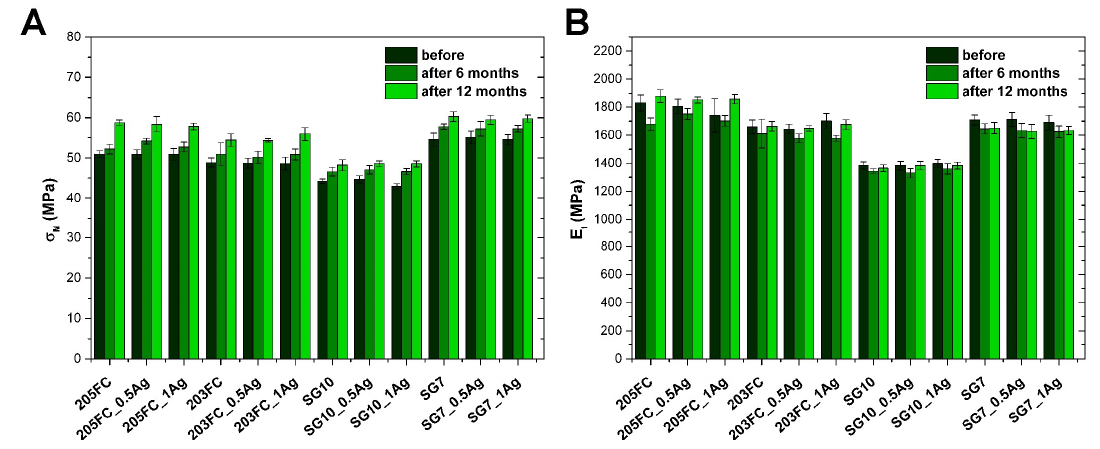
Figure 4. Tensile strength ( A ) and Young’s modulus ( B ) of the materials before and after 6-month and 12-month incubation in deionized water. 12-month incubation in deionized